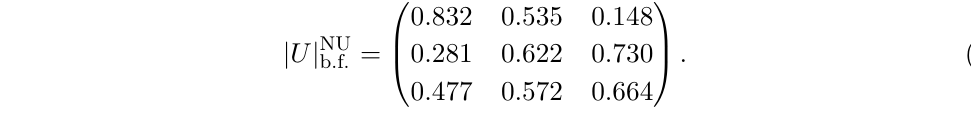
√ 2 | = within 1 σ . The µ 3 2